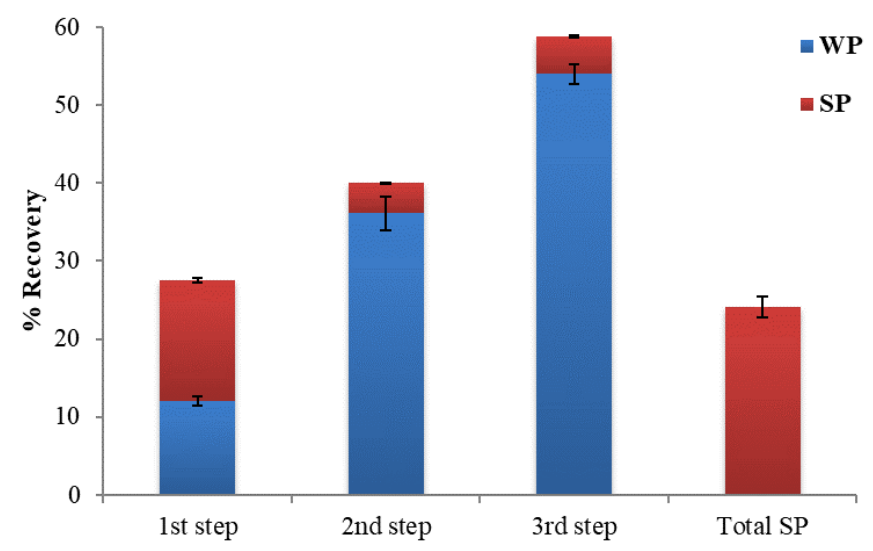
Figure 2. Recovery (%) of polyphenols from OMW with 3% lecithin; WP stands for the Water Phase, SP for the Surfactant Phase, and Total SP for the total micellar phase recovery; standard deviations are presented with error bars.